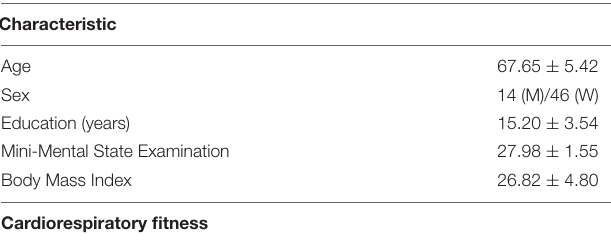
TABLE 1 | Participants’ characteristics, cardiorespiratory fitness, and cognitive